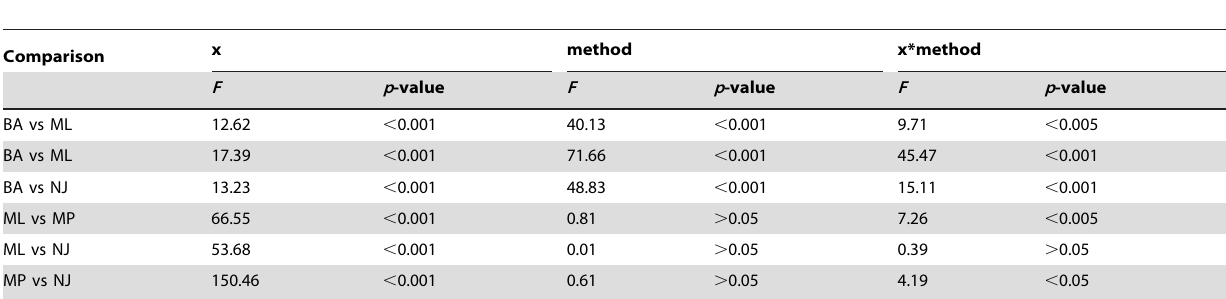
Table 2. Pairwise covariance analyses among the different tree-building methods shown in Table 1.